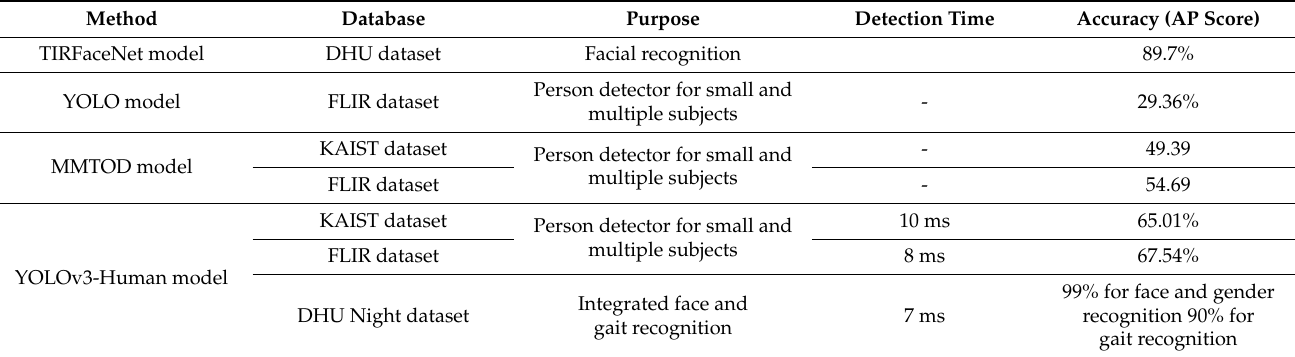
Table 5. Performance comparison of the proposed YOLOv3-Human model with other methods on the same night